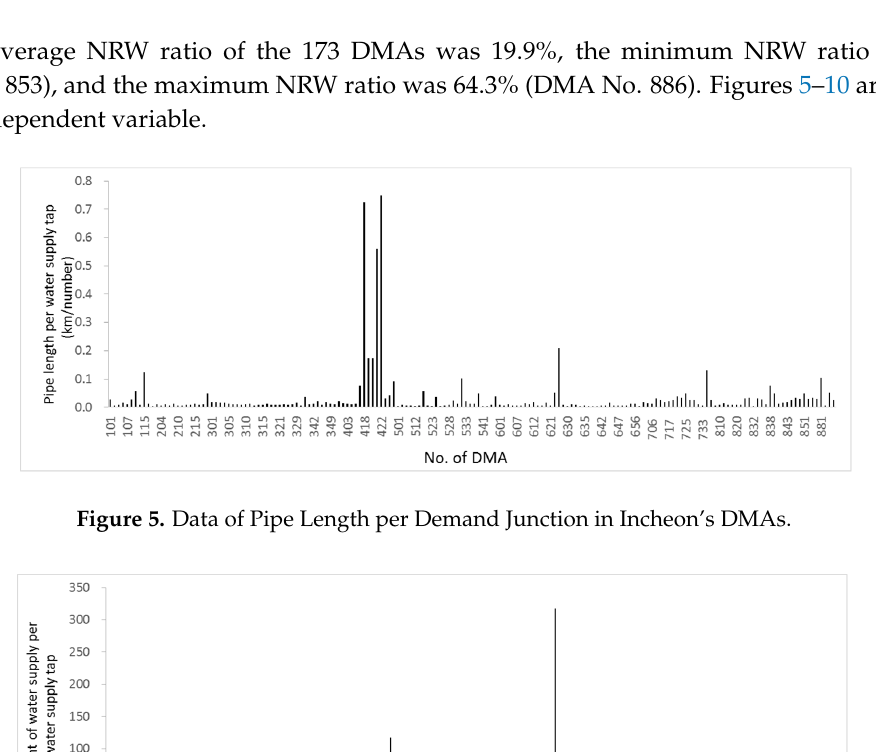
Figure 4. Data Status of NRW ratio in Incheon’s DMAs.